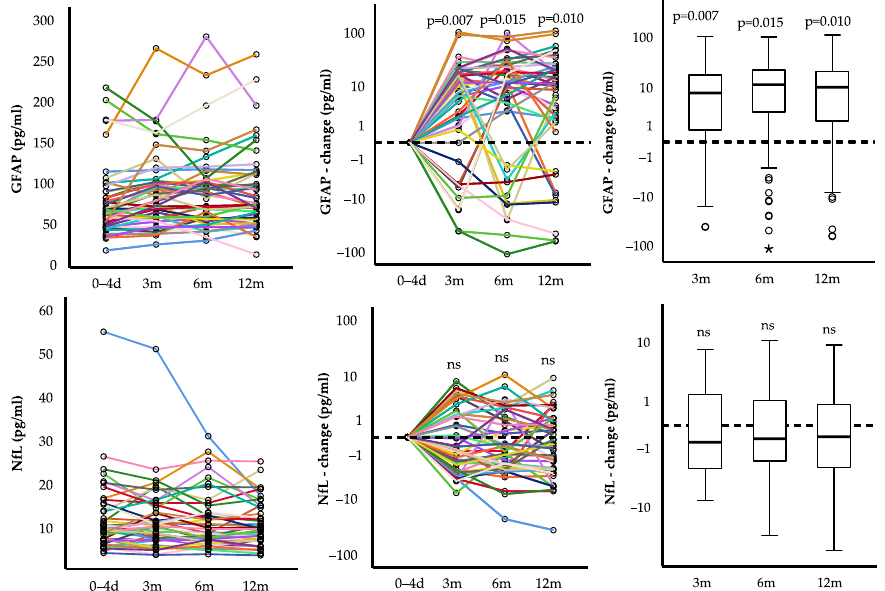
Figure 1. Course of serum GFAP ( top ) and NfL ( bottom ) serum levels after first myocardial infarction. Different colored lines connect the values of individual patients. Each dot represents the value of a patient at one time point. Wilcoxon signed-rank test ( n = 45). * = outlier.